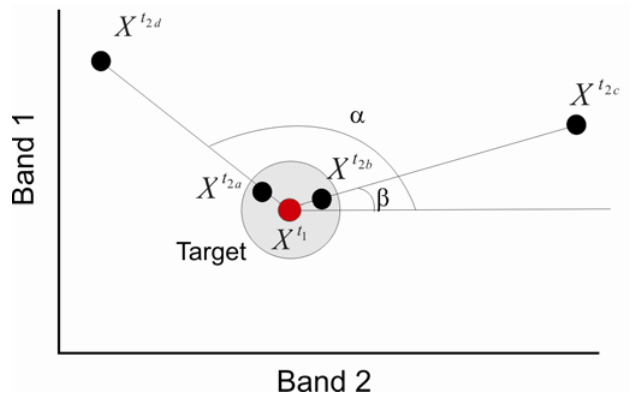
Figure 1. Two-dimensional space having change vectors with the same angles α ( (cid:1850) (cid:3047) (cid:3117) − (cid:1850) (cid:3047) (cid:3118)(cid:3276) and (cid:1850) (cid:3047) (cid:3117) − (cid:1850) (cid:3047) (cid:3118)(cid:3279) ) and β ( (cid:1850) (cid:3047) (cid:3117) − (cid:1850) (cid:3047) (cid:3118)(cid:3277) and (cid:1850) (cid:3047) (cid:3117) − (cid:1850) (cid:3047) (cid:3118)(cid:3278) ). Two of the vectors represent no-change ( (cid:1850) (cid:3047) (cid:3117) − (cid:1850) (cid:3047) (cid:3118)(cid:3276) and (cid:1850) (cid:3047) (cid:3117) − (cid:1850) (cid:3047) (cid:3118)(cid:3277) ) and two represent change ( (cid:1850) (cid:3047) (cid:3117) − (cid:1850) (cid:3047) (cid:3118)(cid:3278) and (cid:1850) (cid:3047) (cid:3117) − (cid:1850) (cid:3047) (cid:3118)(cid:3279) ). The gray disk is a standard deviation for the no-change vectors.